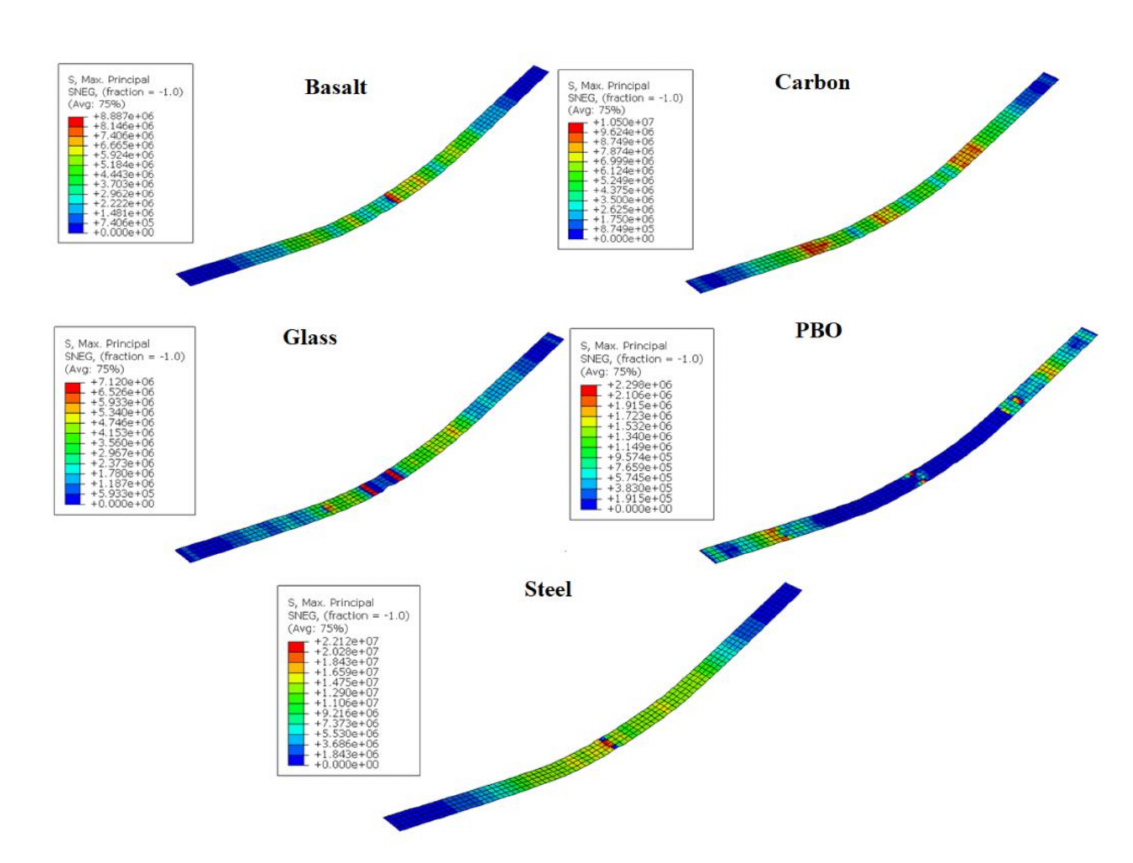
Figure 8. Max. principal stress (N/m 2 ) state of the